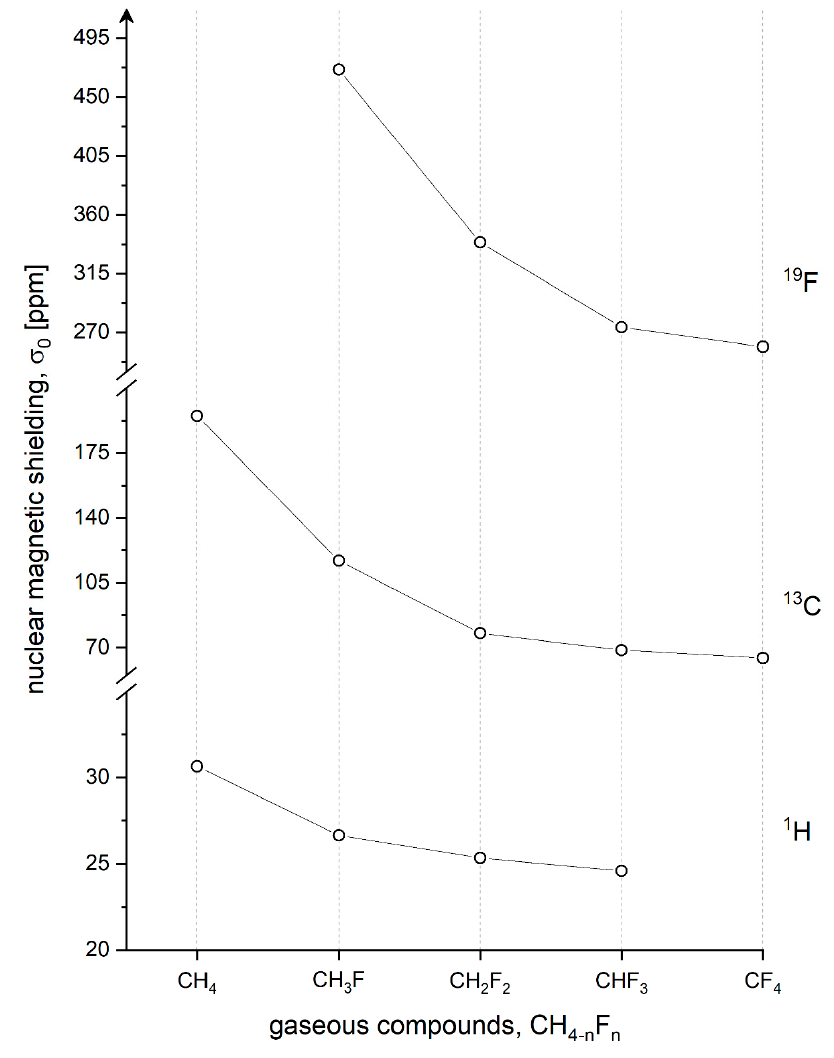
Figure 2. Experimental 19 F, 13 C, and 1 H NMR shielding values in isolated molecules of fluo- romethanes. Each substitution of an electronegative fluorine atom leads to significant deshielding effects for all the nuclei in fluoromethane molecules. Note: The scale of shielding is different for 19 F, 13 C, and 1 H nuclei for better visualization.